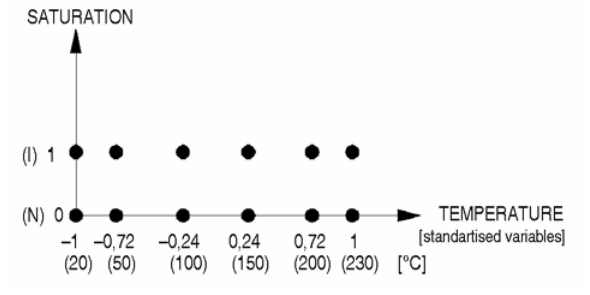
Fig 3. Test points for static tests Fig 4. Experiment plan for dynamic tests. Input data: X –